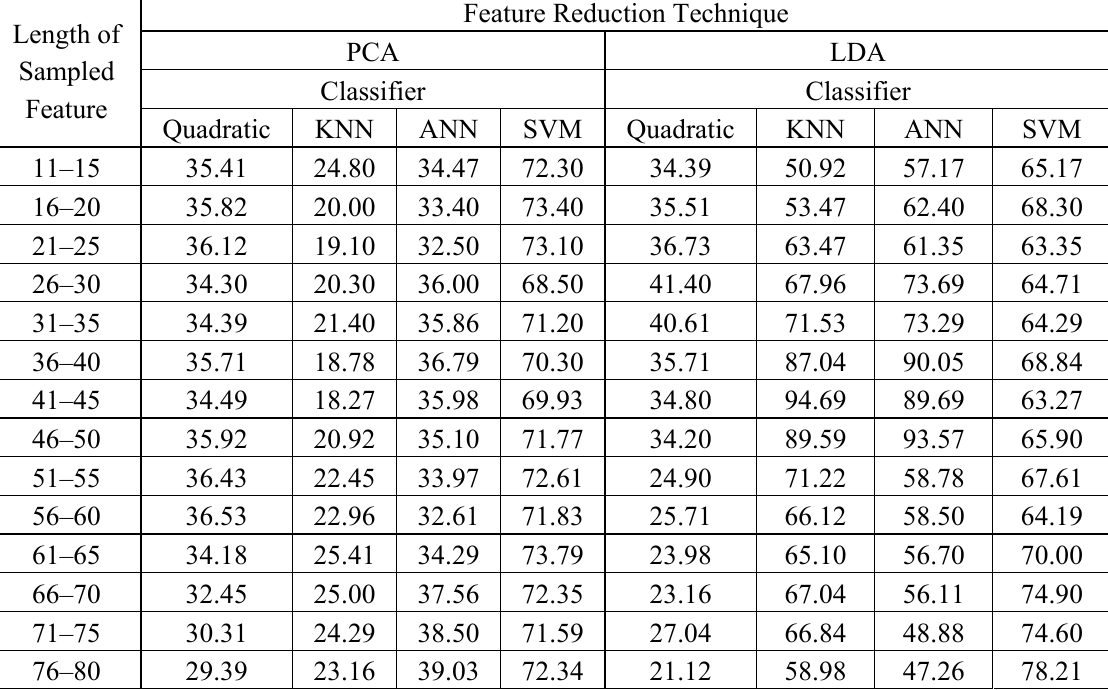
Table 4. Averages of evaluated classification rates for extracted features by FFT method. Length of